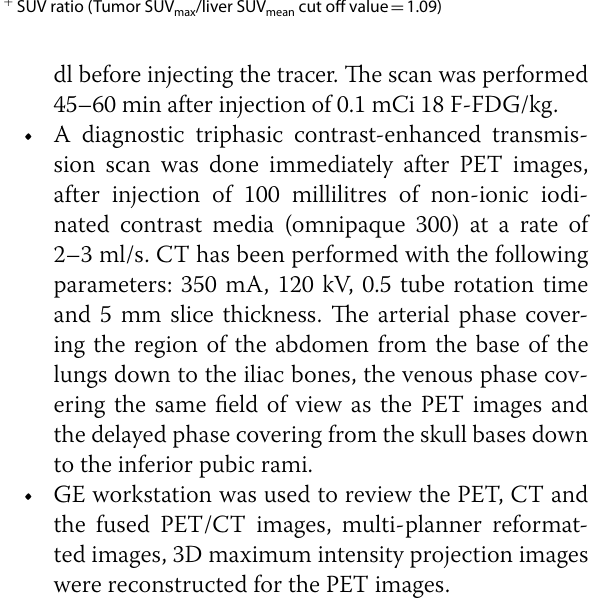
Table 2 ADC, tumor SUV and SUV ratio of post TACE viable and nonviable HCC max